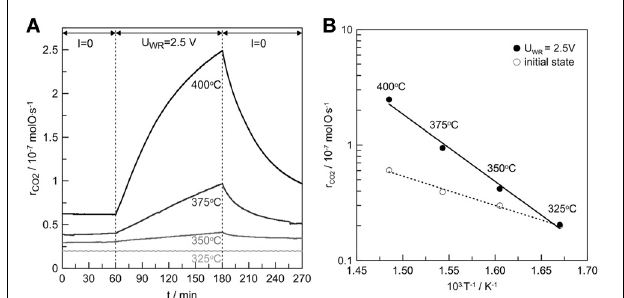
FIGURE 4 | (A) Catalytic rate response to a step change of 2.5V during C 3 H 8 oxidation on Pt/ β (cid:2)(cid:2) -Al 2 O 3 (Ag + ) at 325, 350, 375, and 400 ◦ C. (B) Arrhenius plots at the initial state and upon anodic polarization ( U WR = 2 . 5V) conditions. Reactive mixture: C 3 H 8 /O 2 : 2400ppm/1.2%. Overall flow: 12L/h.